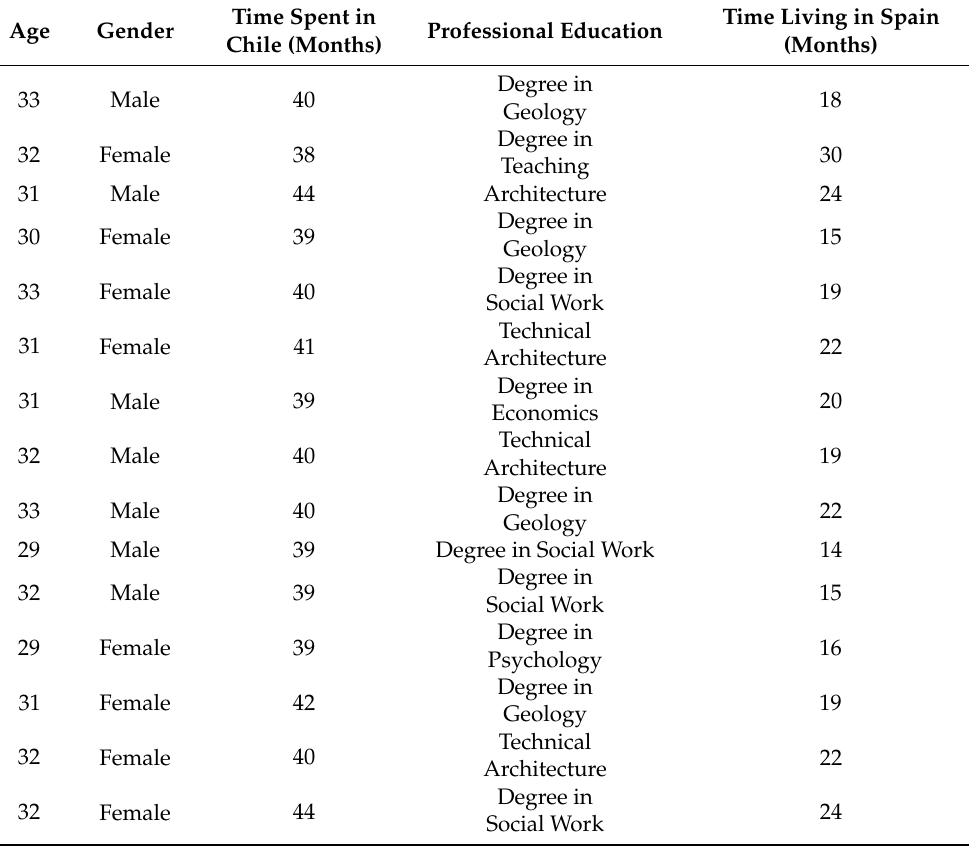
Table 3. Profiles of the interviewees that returned to